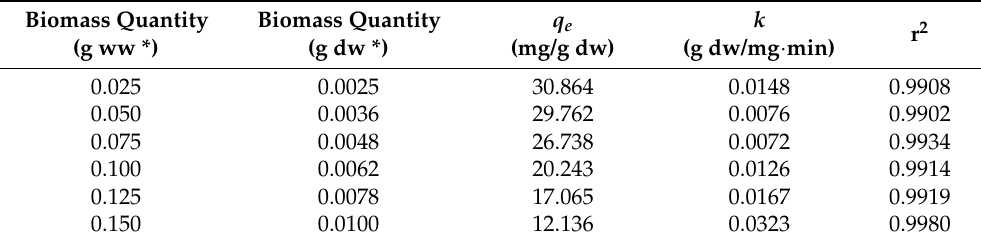
Table 5. Parameters of the pseudo-second-order kinetic model adjusted to the Au biosorption on different quantities of Cladosporium cladosporioides